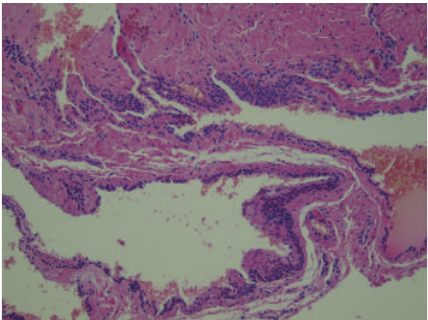
Figure 4: Detail—proliferated glomus cells with round nuclei in the wall of dilated vascular